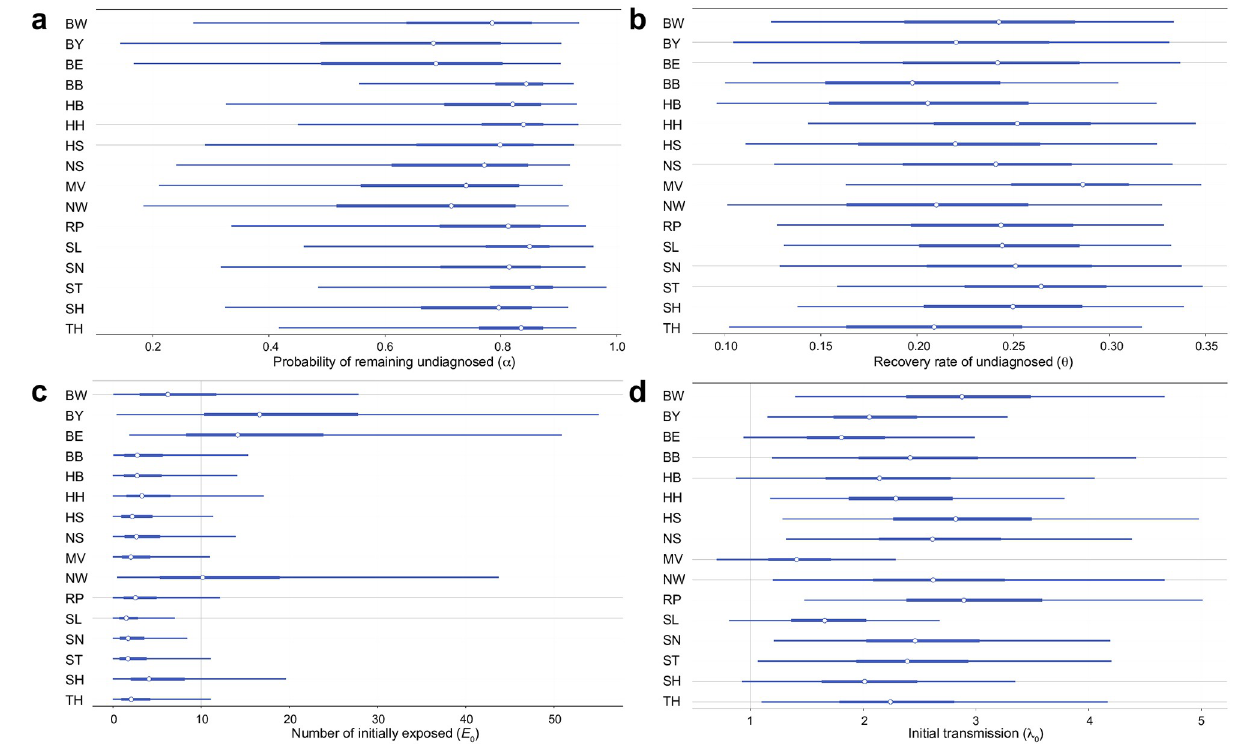
Fig 6. (a) Forest plot depicting 95% credibility intervals for the probability of remaining undetected ( α ) obtained by amortized inference on data from all German federal states. Thin lines depict highest density intervals (HDI), thick lines depict posterior quartiles, and white points depict the corresponding medians of the estimated posteriors; (b-d) Corresponding plots for (b) the recovery rate of undetected ( θ ), (c) the number of initially exposed ( E 0 ), and (d) the initial transmission rate ( λ 0